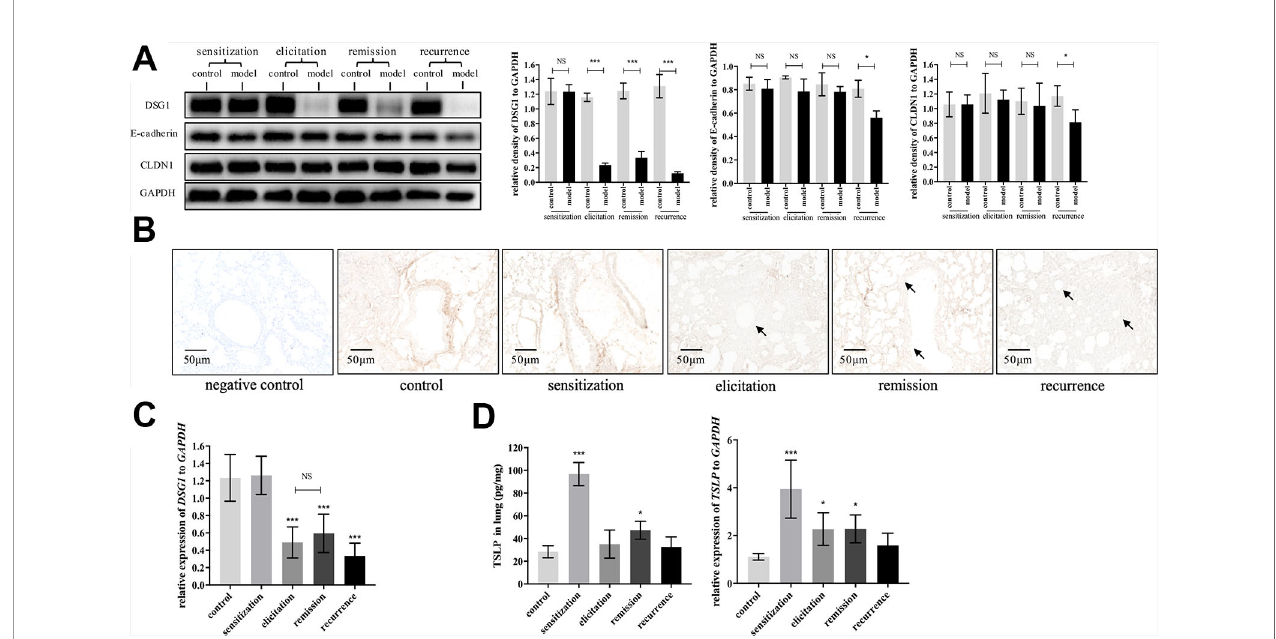
FIGURE 4 | DSG1 remained de fi cient constantly in the asthmatic recurrence model. Dynamic changes of DSG1 and TSLP in different phases of the HDM-induced asthma recurrence model, including sensitization (day 15), elicitation (day 24), remission (day 31), and recurrence (day 41), were observed. DSG1 protein expression in different phases was determined by (A) Western blot and (B) IHC-P (n = 6, scale bar = 50 m m). Arrows pointed signi fi cantly reduced DSG1 protein around the bronchial wall after asthma exacerbated, and most importantly, DSG1 remained de fi cient in remission phase. Data on protein level suggested that DSG1, instead of CLDN1 or E-cadherin, might be the vital factor contributed to the compromise of bronchial epithelial barrier; (C) pulmonary gene expression of DSG1 detected by RT-QPCR showed a similar trend as protein expression described above; (D) Protein and mRNA level of TSLP in lung in different phases of asthma recurrence model were determined by ELISA and RT-QPCR, respectively. Results indicated that pulmonary TSLP were highly expressed in remission, which was diametrically opposed to DSG1. (All data represent mean ± SD from three independent experiments performed in triplicate, n = 6, * P < 0.05, *** P < 0.001 versus control). HDM, house dust mite; DSG1, desmoglein 1; TSLP, thymic stromal lymphopoietin; NS, P ≥